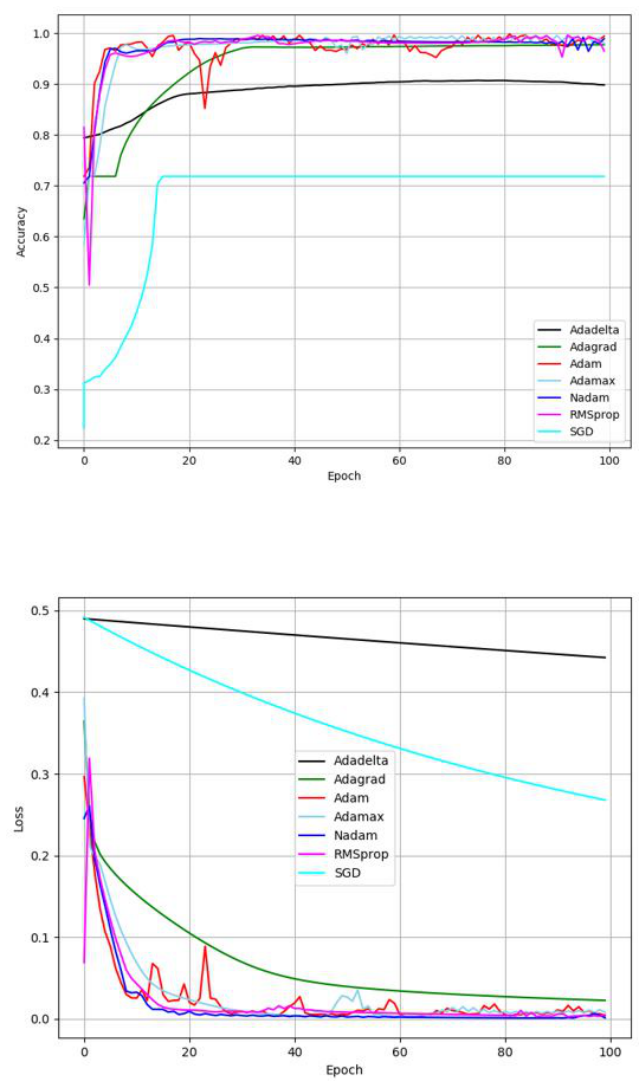
Figure 11. Performance of different optimizers for the LSTM model.